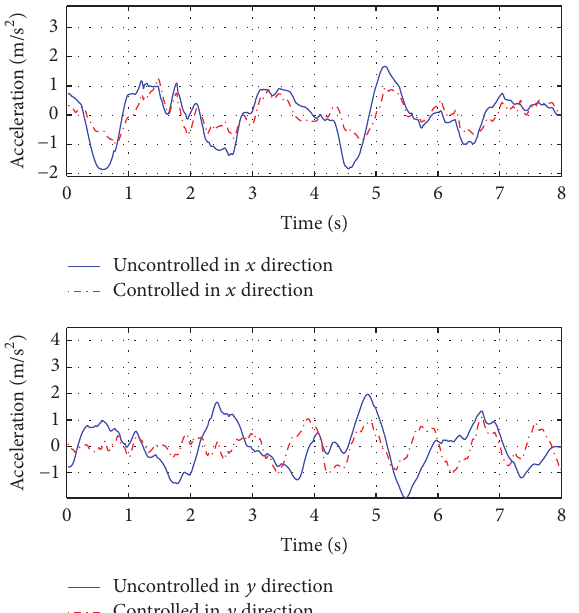
Figure 14: Acceleration responses of the tower top under earth- quake.